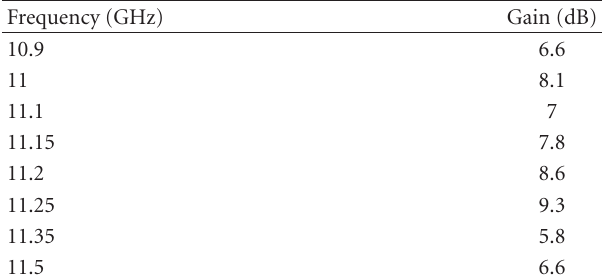
Table 1: Measured Gain versus Frequency (Broadside Configura-